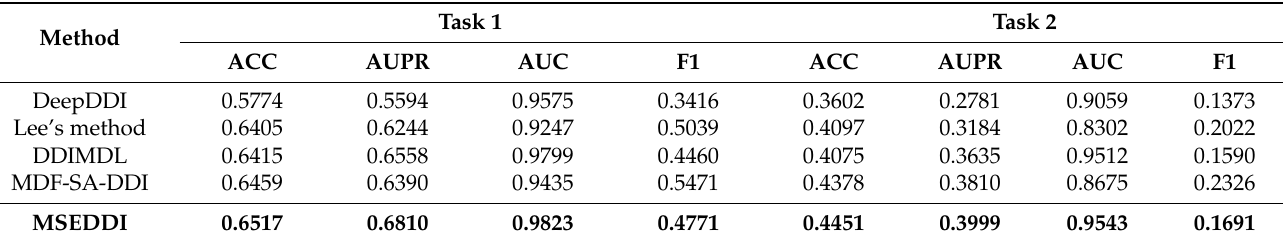
Table 1. The performance of all methods on Dataset 1.